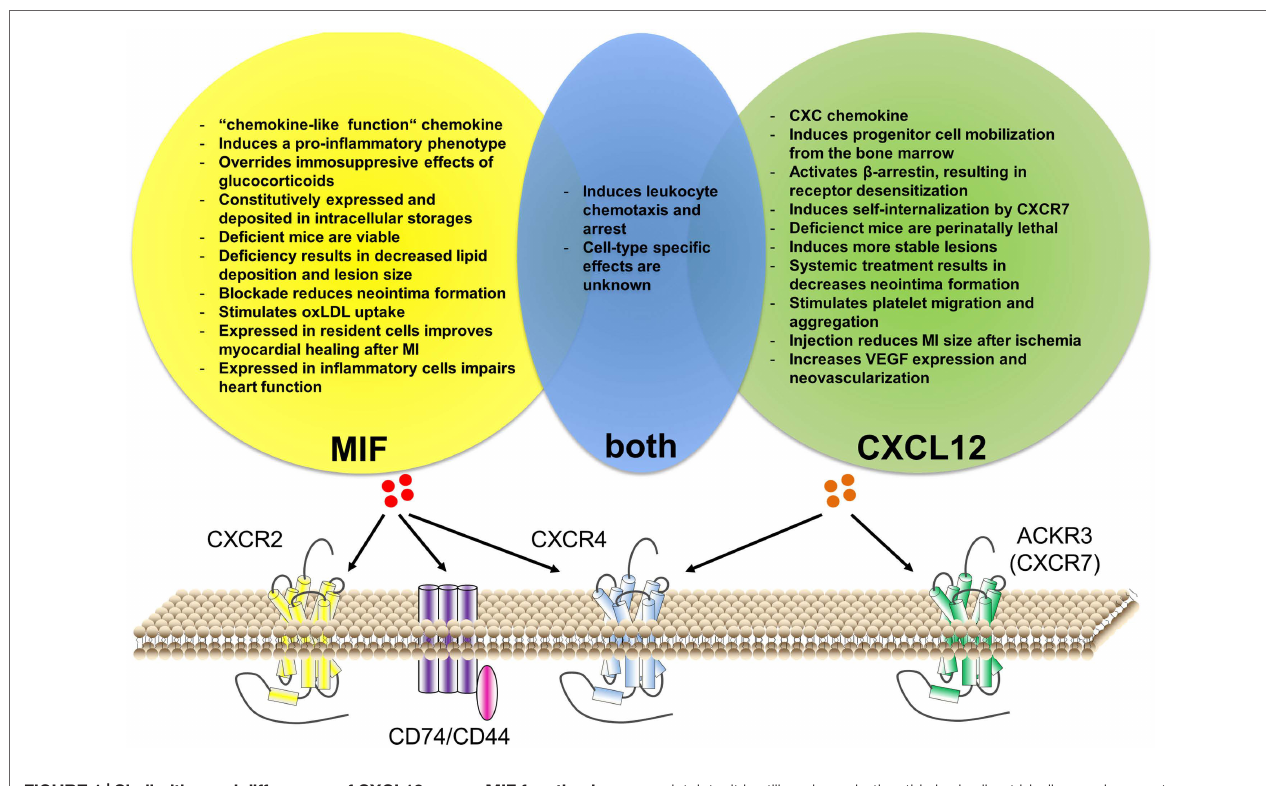
FiGURe 1 | Similarities and differences of CXCL12 versus MiF function in cardiovascular disease. Both CXCL12 and MIF can bind to CXCR4. Additionally, CXCL12 can bind to ACKR3 (CXCR7), while MIF binds to CXCR2 and CD74/CD44. Although MIF interaction with ACKR3 has been described for